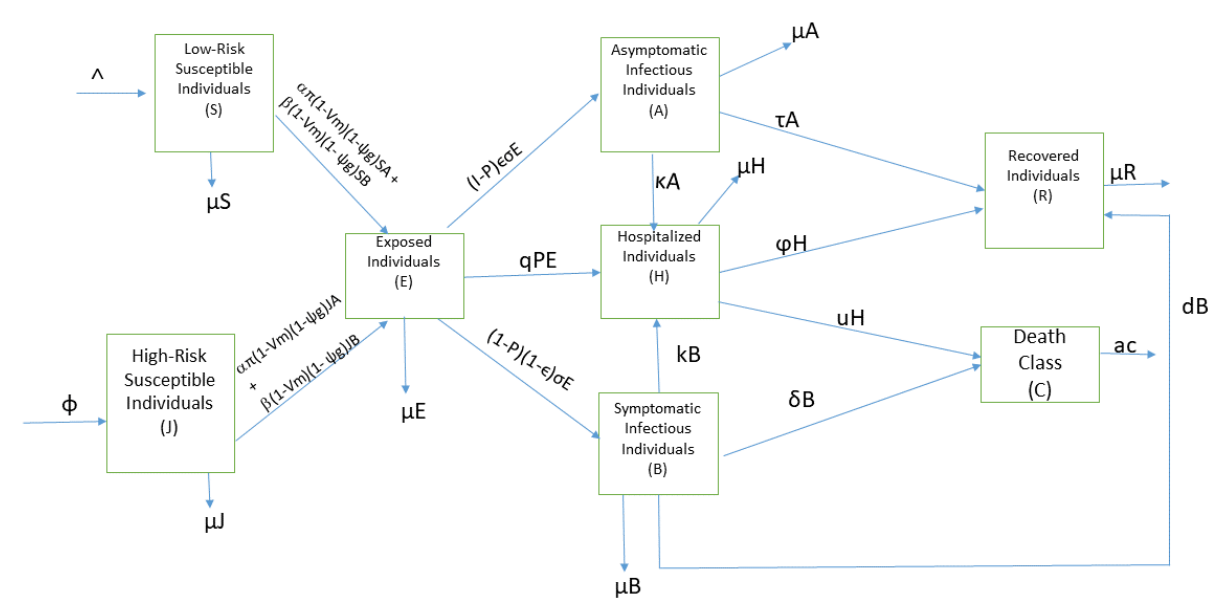
Figure 1. Scheme of COVID-19